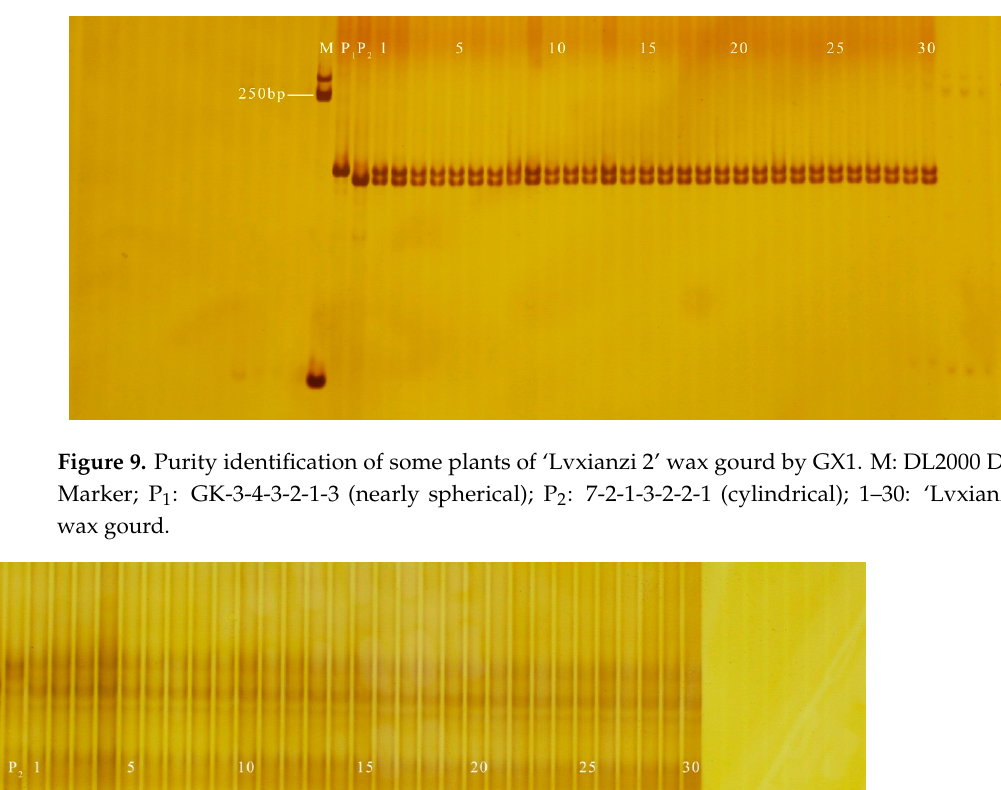
Figure 9. Purity identification of some plants of ‘Lvxianzi 2 ′ wax gourd by GX1. M: DL2000 DNA Marker; P 1 : GK-3-4-3-2-1-3 (nearly spherical); P 2 : 7-2-1-3-2-2-1 (cylindrical); 1–30: ‘Lvxianzi 2 ′ wax gourd.